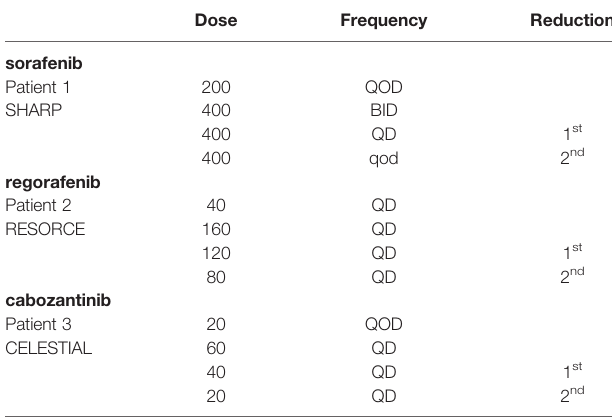
TABLE 1 | Dosing regiments for sorafenib, regorafenib, and